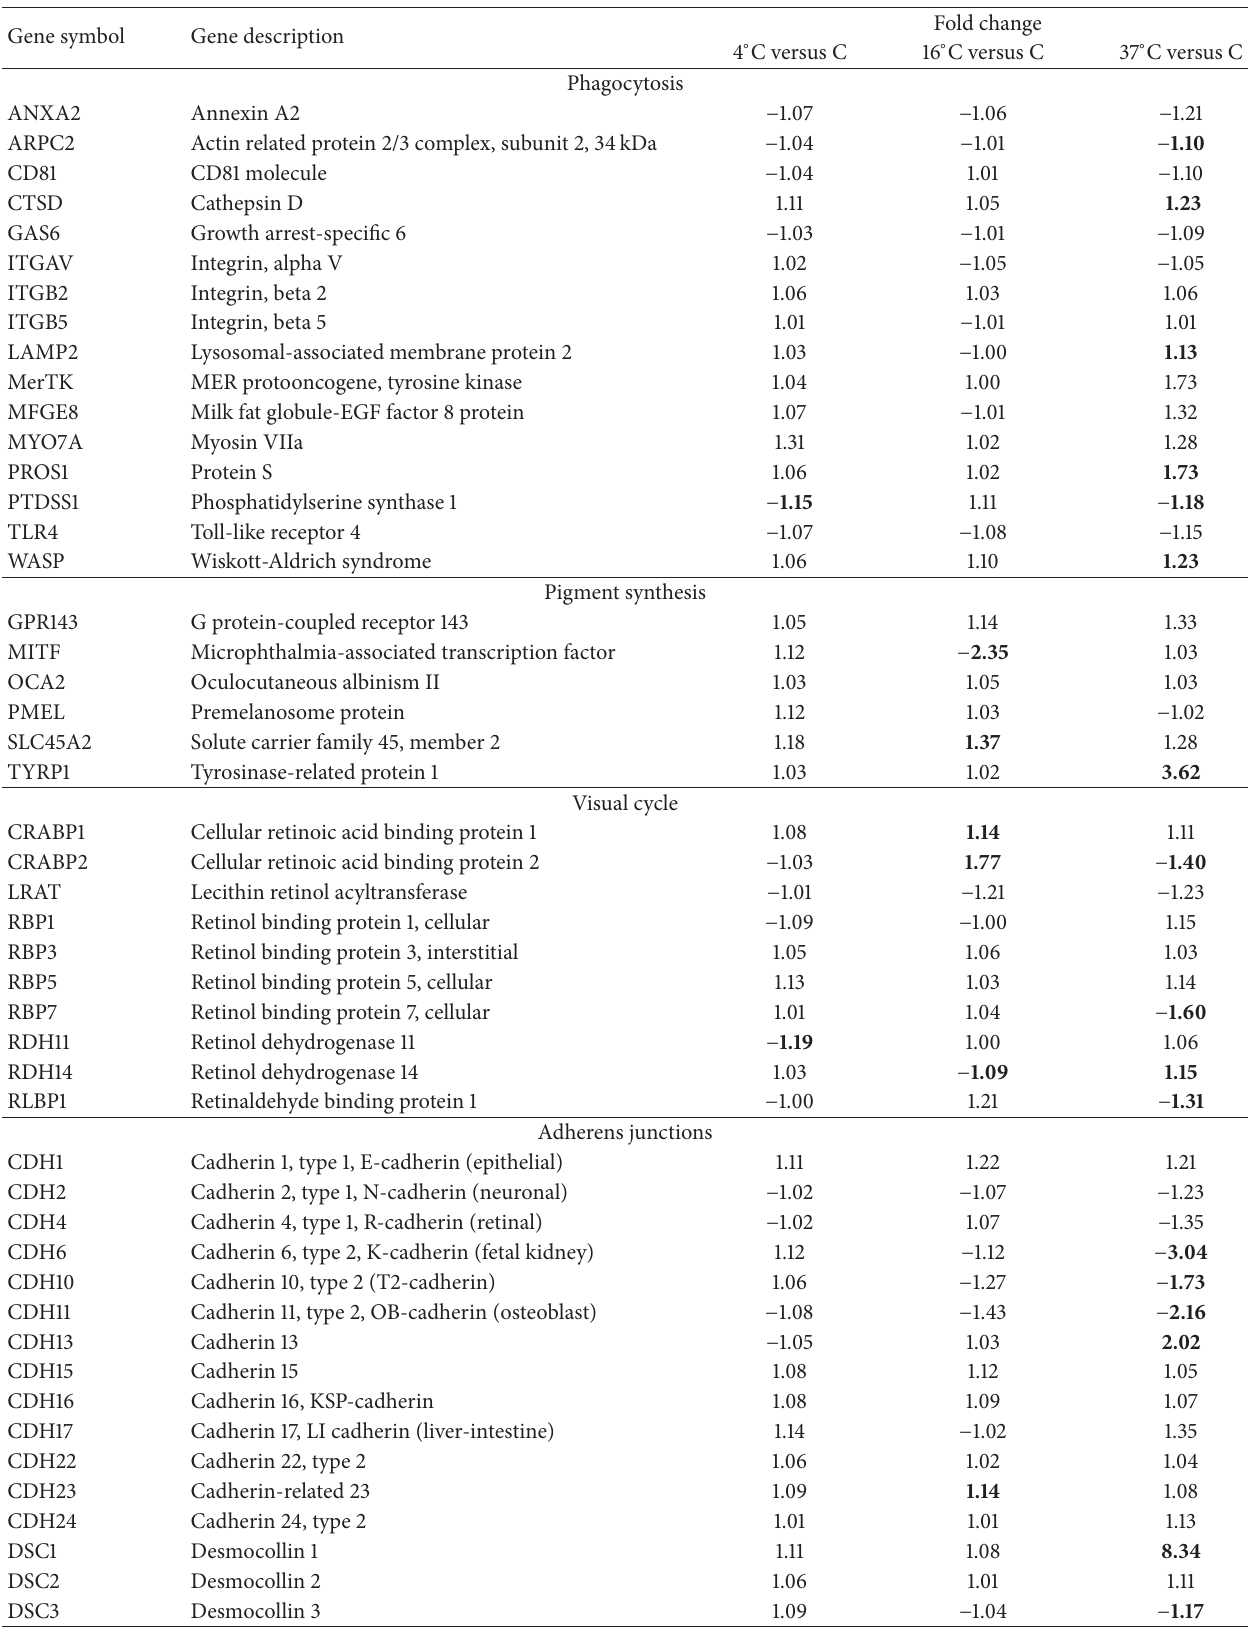
Table 1: Expression of genes involved in key functions of the RPE at different temperatures compared to